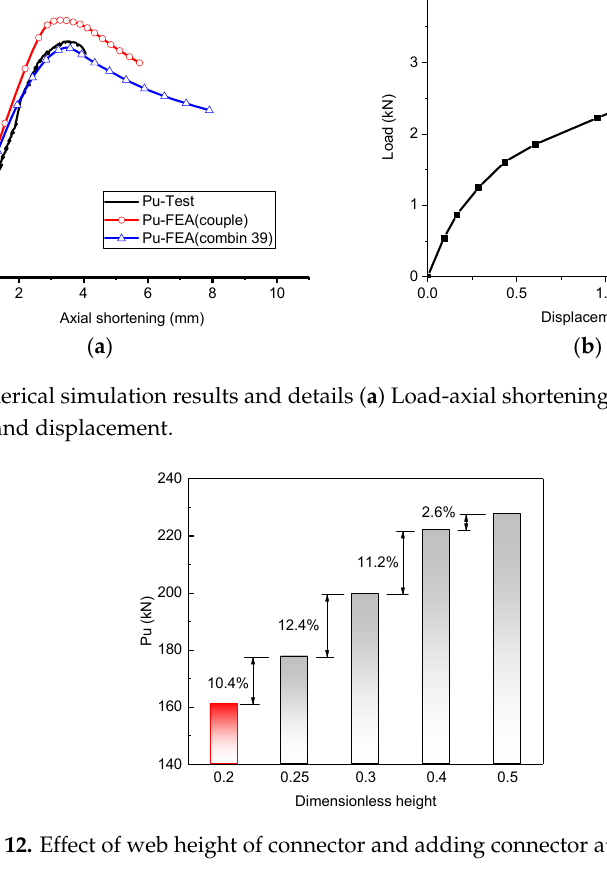
Figure 10. Mises stress of specimens (unit: N/m 2 ). Appl. Sci. 2019 , 1 , x FOR PEER REVIEW